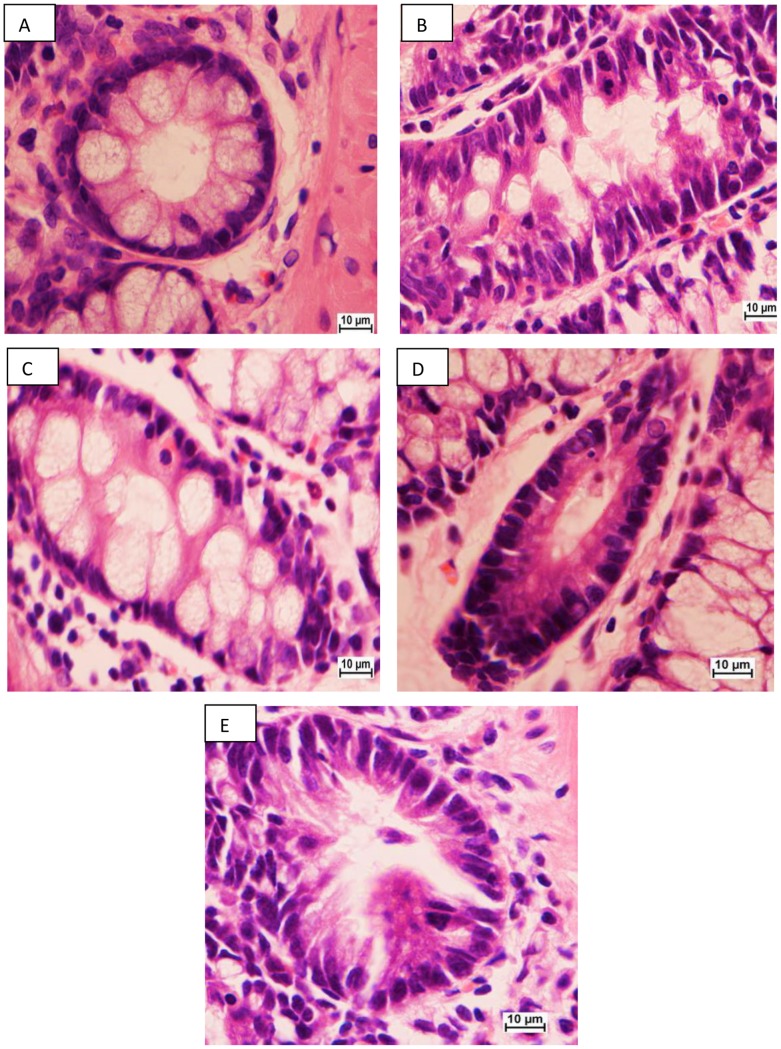
Effects of A. ilicifolius on histological sections of AOM-induced ACF.All sections were cut parallel to the muscular layer. (A) Normal colon mucosa showing circular shape of the crypts and nuclei lining the crypt, basal nuclear polarity and absence of stratification. (B) AOM treated group showed elongated ACF with narrow lumen, marked nuclear atypia (elongated and stratified nucleus), loss of basal nuclear polarity and increases proliferation with decreases in goblet cells (C) Reference group, 5-Fluorouracil + AOM showed slightly elongated ACF and nuclei, slight decreased in goblet cells and no nuclear stratification. (D) 250 mg/kg A. ilicifolius + AOM showed elongated ACF and nuclei, slight decreases in goblet cells and nuclei showed slightly nuclear stratification (E) 500 mg/kg A. ilicifolius + AOM showed ACF with slightly rounded shape and without stratified nuclei, slightly decreased in number of goblet cells and proliferation of nuclei (H & E stain 100×).